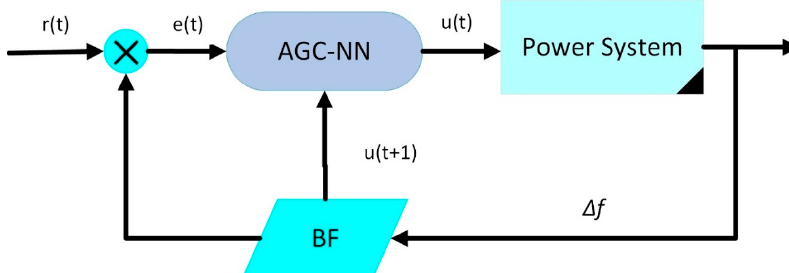
Figure 7. Training process of BF-NN model.